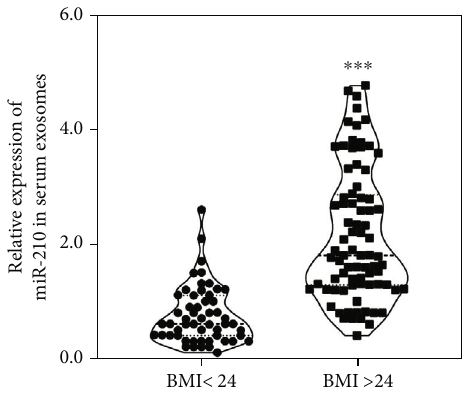
Figure 1: The miR-210 level in exosomes from serum in patients with type 2 diabetes mellitus. A total of 134 patients with type two diabetes mellitus were divided into two groups according the body mass index. There were 54 patients in BMI < 24 : 0 group and 80 patients in BMI > 24 : 0 group. The exosomal miR-210 levels from serum were detected by qRT-PCR. ∗∗∗ P < 0 : 001